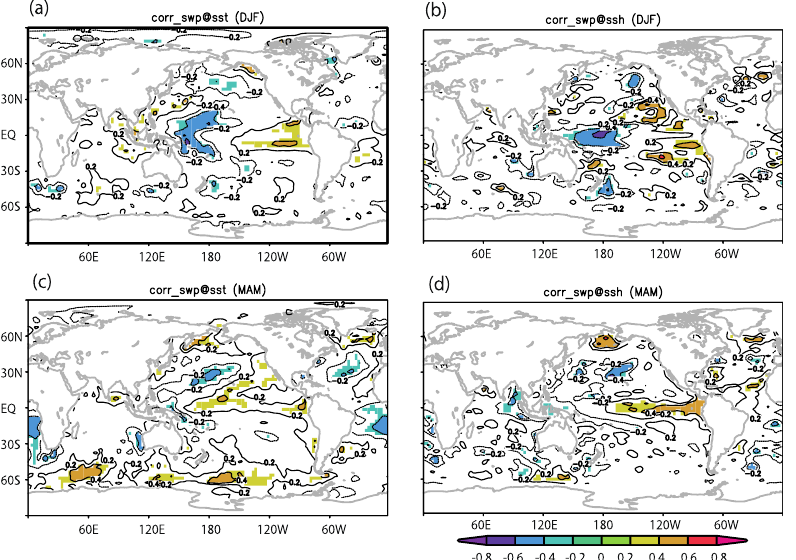
Figure 4. Same as Figure 2 but for the TCF anomaly over the SWP region (averaged over 10 – 30° S, 150 – 180° E). ( a ) DJF SST, ( b ) DJF SSH, ( c ) MAM SST, ( d ) MAM SSH.